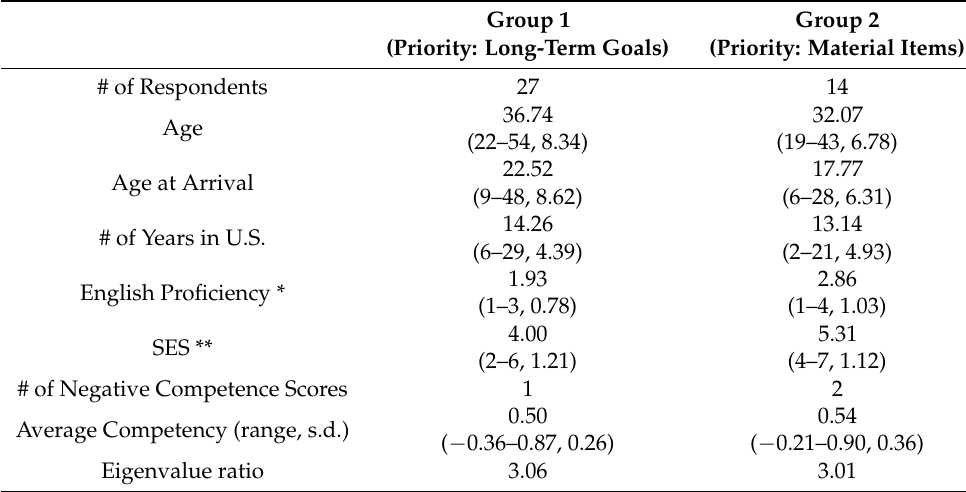
Table 3. Cultural consensus analysis by subgroup (Sample